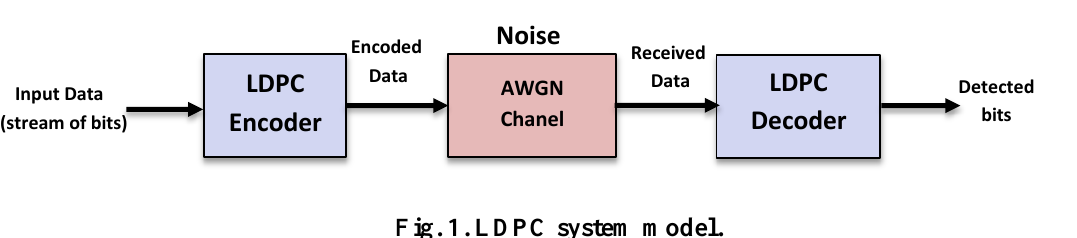
Fig. 1. LDPC system